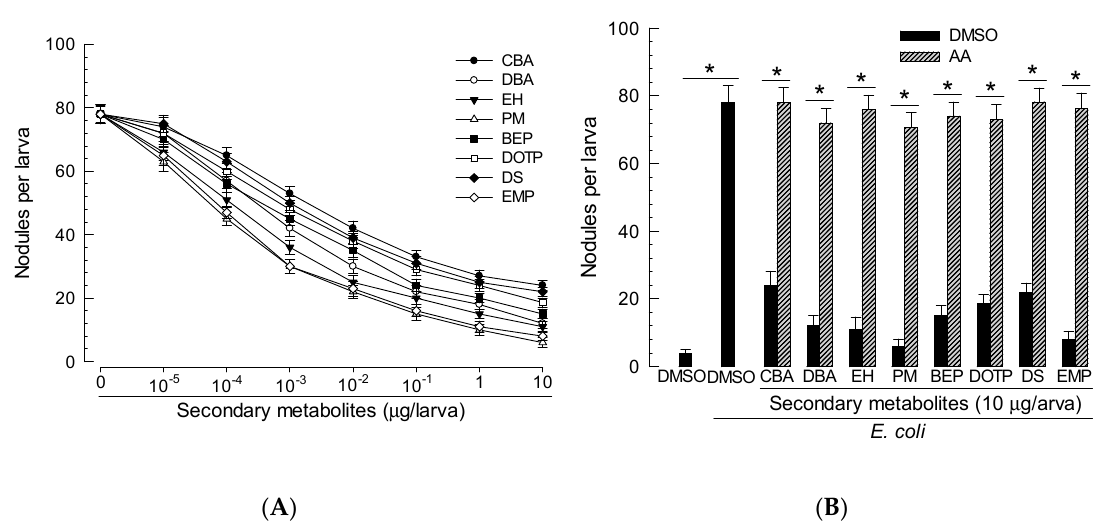
Figure 6. Immunosuppressive activities of eight PLA 2 inhibitors against nodule formation of S. exigua against bacterial infection. The eight compounds are bis(2-ethylhexyl) phthalate (BEP), o-cyanobenzoic acid (CBA), dibutylamine (DBA), dioctyl terephthalate (DOTP), docosane (DS), 2-ethyl-1-hexanol (EH), 3-ethoxy-4-methoxyphenol (EMP), and phthalimide (PM). ( A ) Dose effects of the inhibitors on suppressing nodulation. ( B ) Rescue effects of arachidonic acid (AA’, 10 µg/larva) on the phagocytosis suppressed by the inhibitors. Control used dimethyl sulfoxide (DMSO) for solvent control. Each treatment was replicated three times with independent insect samples. Asterisks above standard deviation bars indicate significant differences between treatments at Type I error = 0.05 (LSD test).